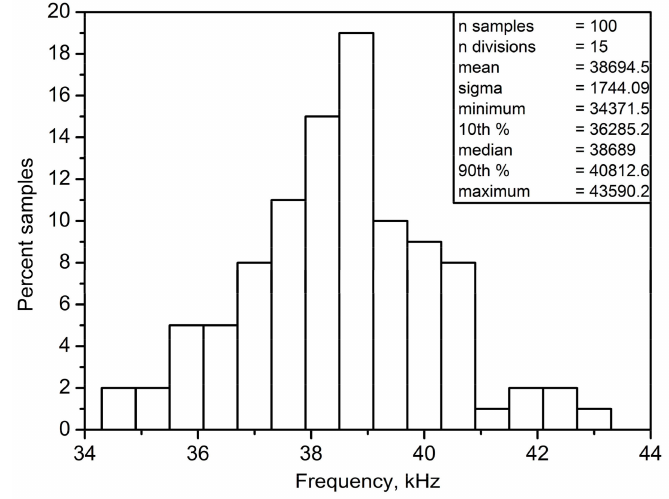
Figure 17. Histogram of Monte-Carlo sensitivity analysis of BP filter at V o2 when V i1 = V in and V i2 =